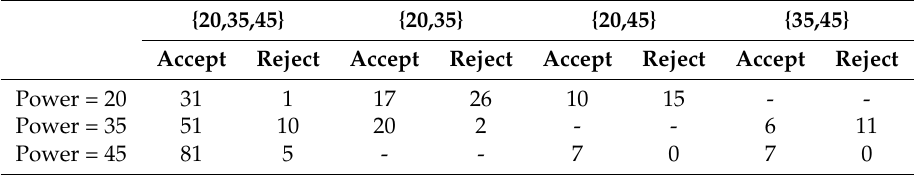
Note: Rows sum to